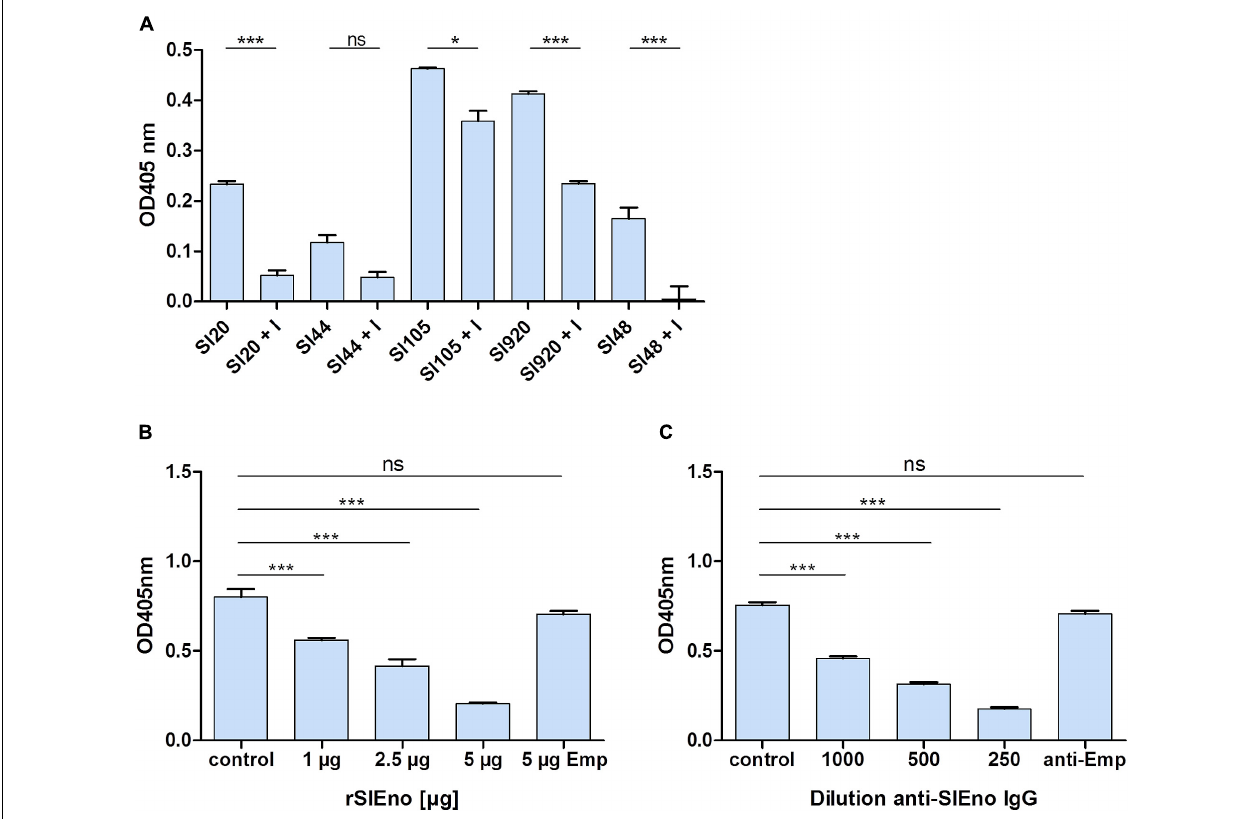
FIGURE 8 | Binding of surface-bound SlEno to plasminogen is inhibitable by ε -aminocaproic acid and inhibition of S. lugdunensis binding to plasminogen by rSlEno or anti-rSlEno antibodies. (A) The inhibition of enolases by ε -aminocaproic acid (EACA = I) of different S. lugdunensis strains coated in microtiter plates was performed in the presence of tPA, D-valyl-L-lysyl-p-nitroaniline hydrochloride, EACA, and Plg. Results are shown as the mean of two independent experiments with the standard deviation (SD). Statistical analyses were performed using one-way ANOVA with Bonferroni multiple comparisons post-test (* p < 0.05, *** p < 0.001, ns, not significant). (B) To determine the competitive inhibition of the rSlEno with S. lugdunensis cells to Plg, microtiter plates were coated with 1 µ g of Plg, and increasing concentrations of rSlEno were added. After washing, formalin-fixed S. lugdunensis cells were added to the wells. Adherence of the S. lugdunensis cells to Plg was determined by anti- S. lugdunensis Abs. Control–no addition of rSlEno, 5 µ g Emp–5 µ g of the ECM-binding protein extracellular matrix binding protein (Emp) was used as negative control. (C) Plg-coated microtiter plates were incubated with formalin-fixed S. lugdunensis cells, which were prior incubated with anti-SlEno IgG. Binding was measured by the detection of the bacteria by anti- S. lugdunensis IgG. Control–no anti-SlEno IgG was added to the reaction, anti-Emp–negative control using anti-Emp IgG. Results of (B,C) are shown as the mean of three independent experiments with the standard deviation (SD). Statistical analyses were performed using one-way ANOVA with Bonferroni multiple comparisons post-test (*** p < 0.001, ns, not